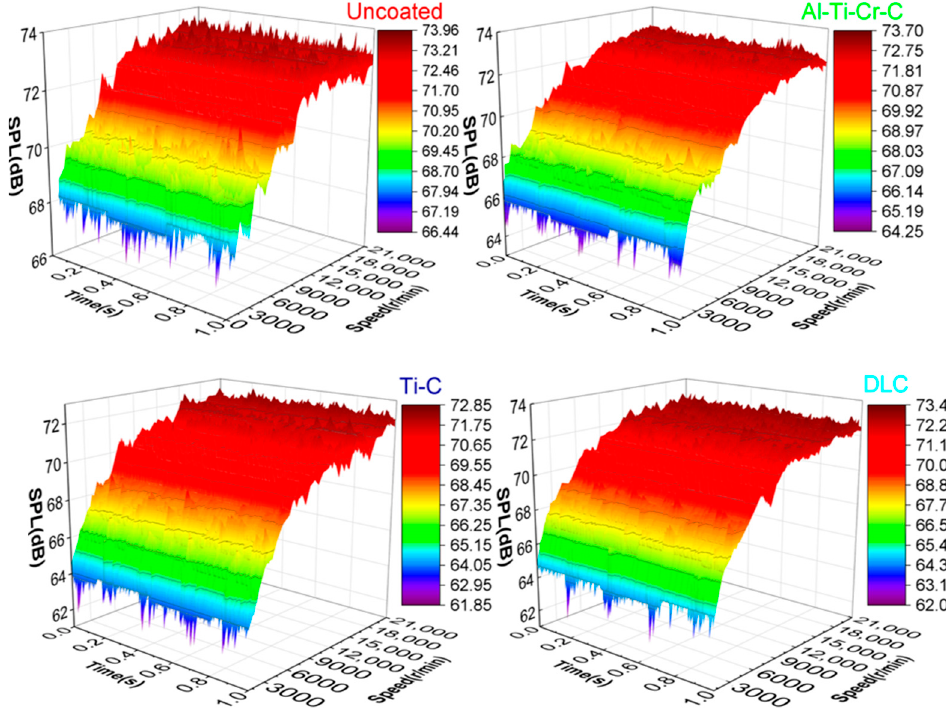
Figure 8. The change graph of rotation speed–time–sound pressure level .